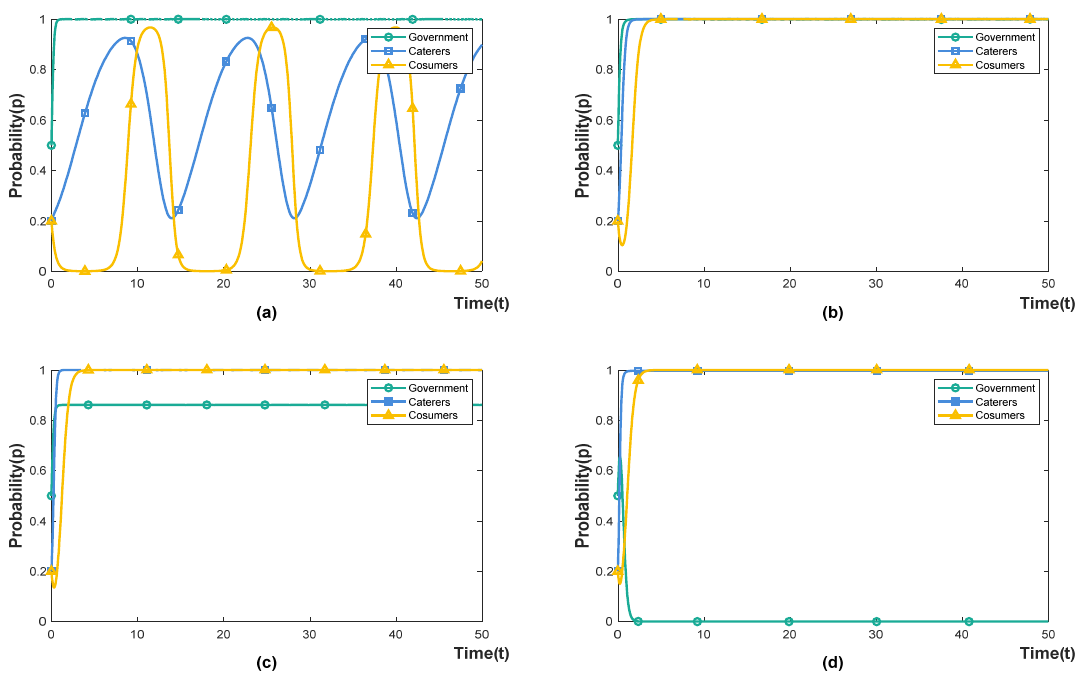
Figure 2. The influence of government incentives. ( a ) α = 0.2. ( b ) α = 0.4. ( c ) α = 0.6. ( d ) α = 0.8 .